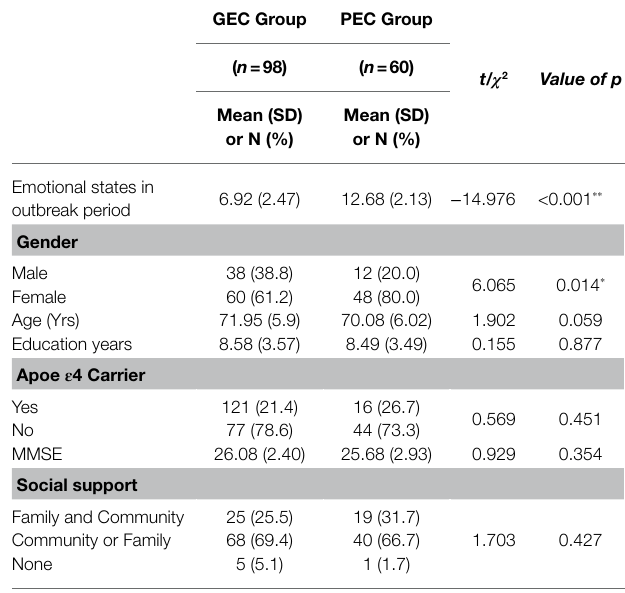
TABLE 3 | Changes of emotional states and protective behaviors between two outbreak and remission periods of COVID-19 pandemic ( N = 158).